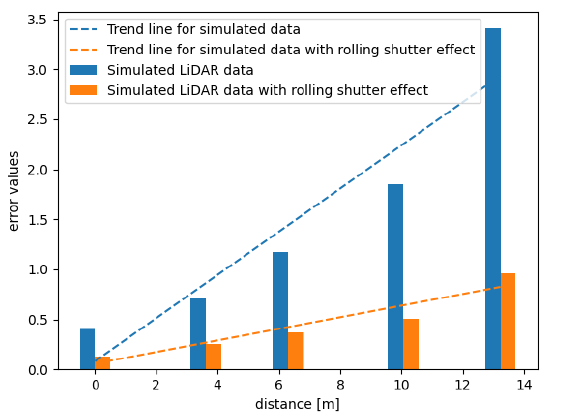
Figure 14. SLAM accuracy metric for simulated data generated for the second track with and without the rolling shutter